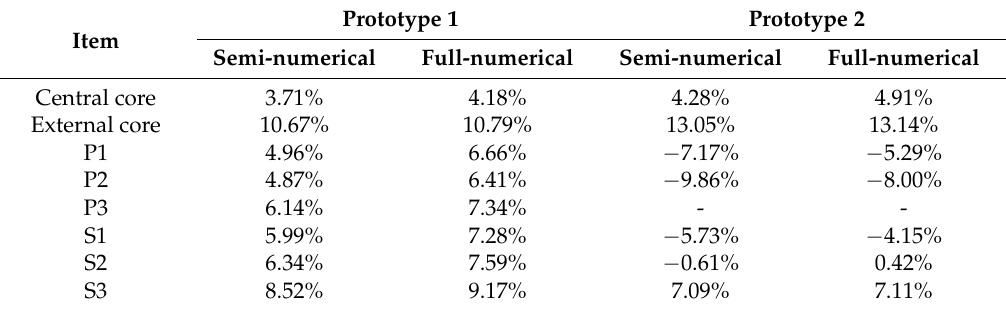
Figure 8. Comparison between simulated and measured temperature at different locations: (a) Prototype 1 and (b) Prototype 2. Table 6. Relative deviations between predicted and measured temperatures.